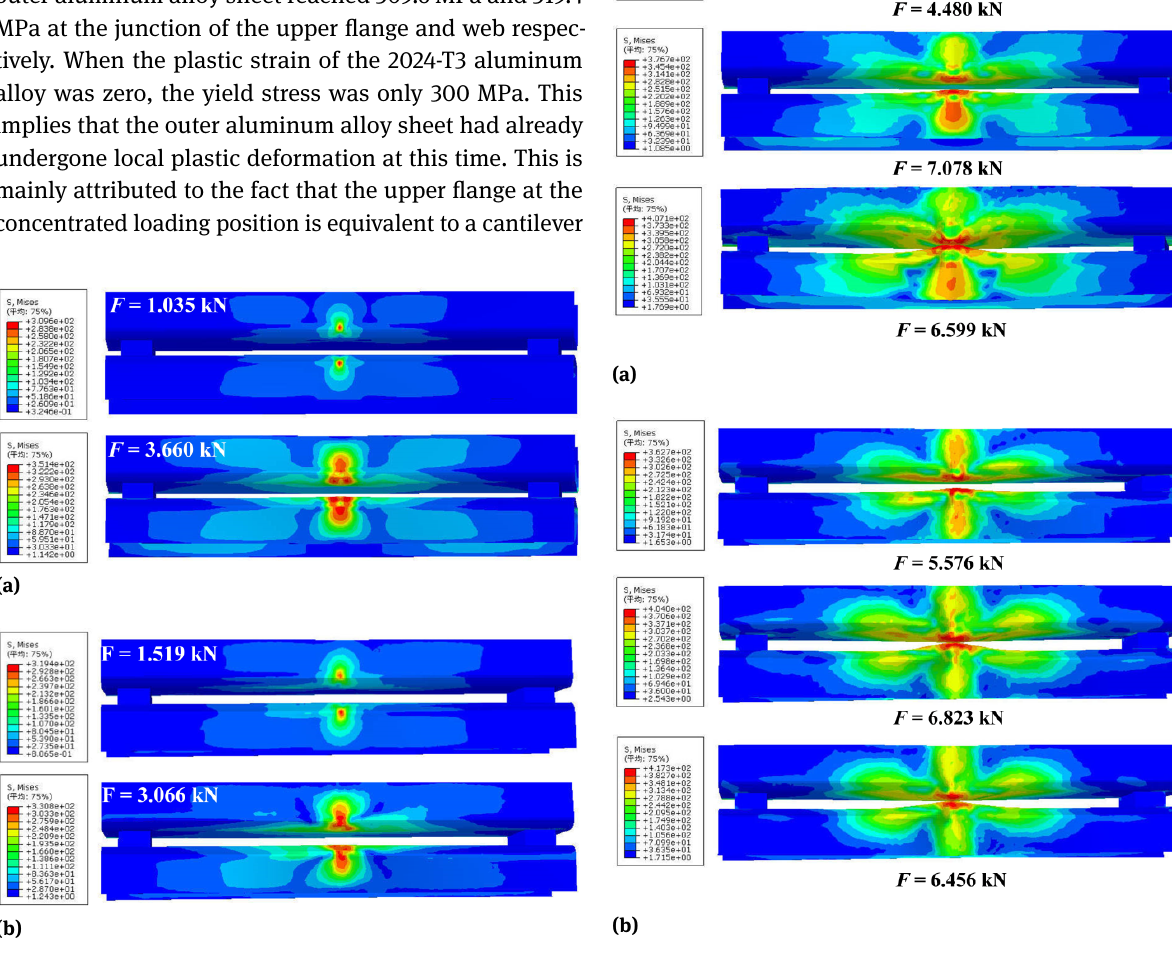
Figure 10: Stress distribution and deformation of outer aluminum sheet under different concentrated loads: (a) SHCXL-A and (b) SHCXL-B.